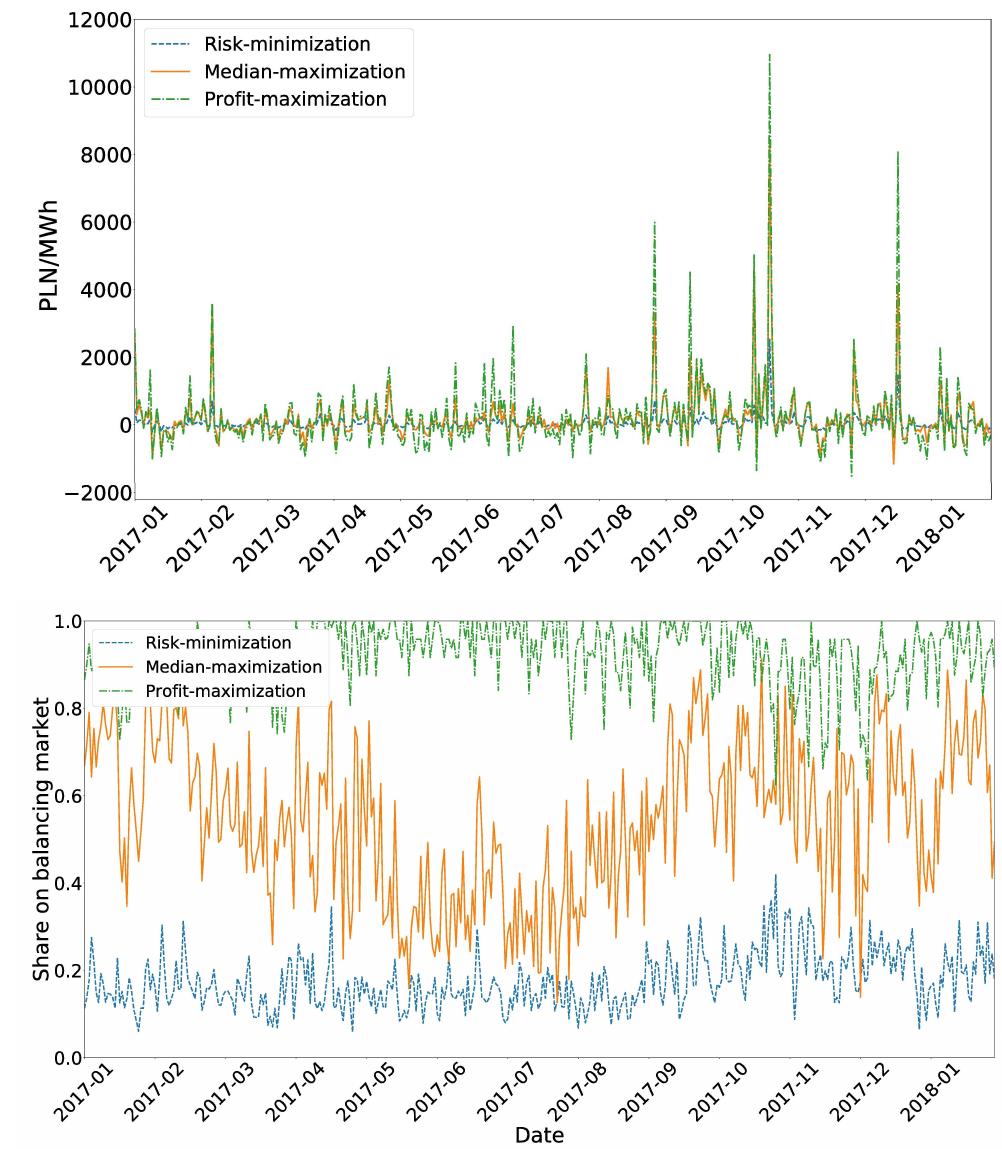
Figure 5. Daily profits ( top panel ) and daily shares of sale on the balancing market ( bottom panel ) for the considered strategies constructed using the Quantile Regression Averaging (QRA)